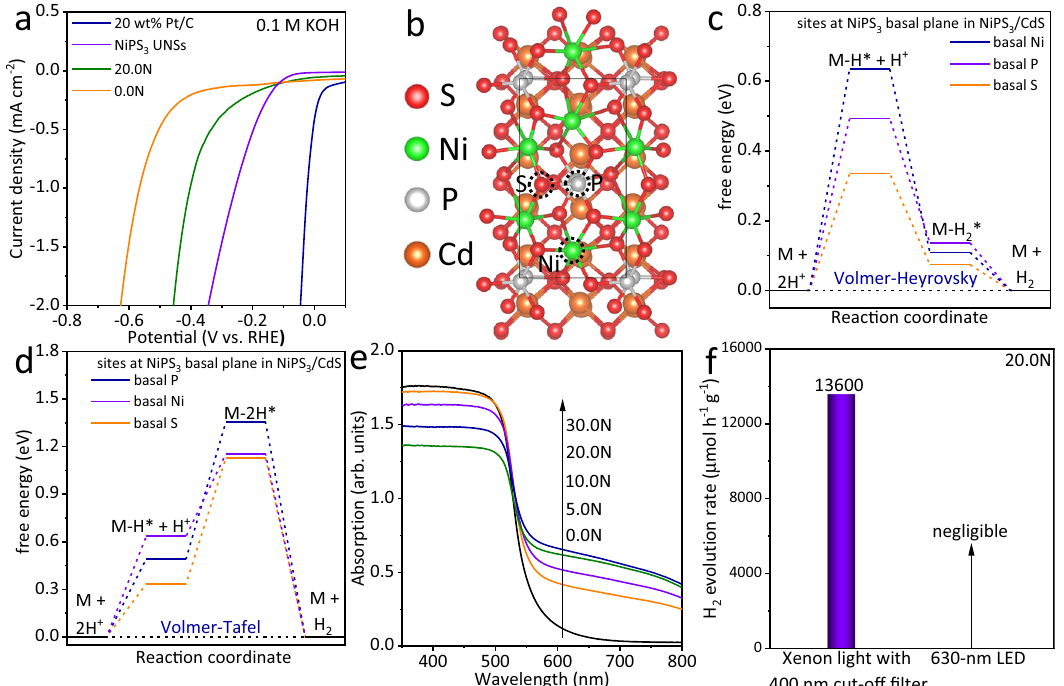
Fig. 6 | Surface catalytic reactions and light absorption of NiPS 3 /CdS system. a Electrochemical HER activities in 0.1M KOH aqueous solution for 0.0N, 20.0N, NiPS 3 UNSsand20wt%Pt/C. b top-viewatomicstructureofNiPS 3 /CdSshowingthe Ni, P and S basal sites. c The calculated free energy diagrams of HER following the Volmer-Heyrovsky pathway on the Ni, P and S sites of NiPS 3 basal plane in NiPS 3 / CdS system. d The calculated free energy diagrams of HER following the Volmer-